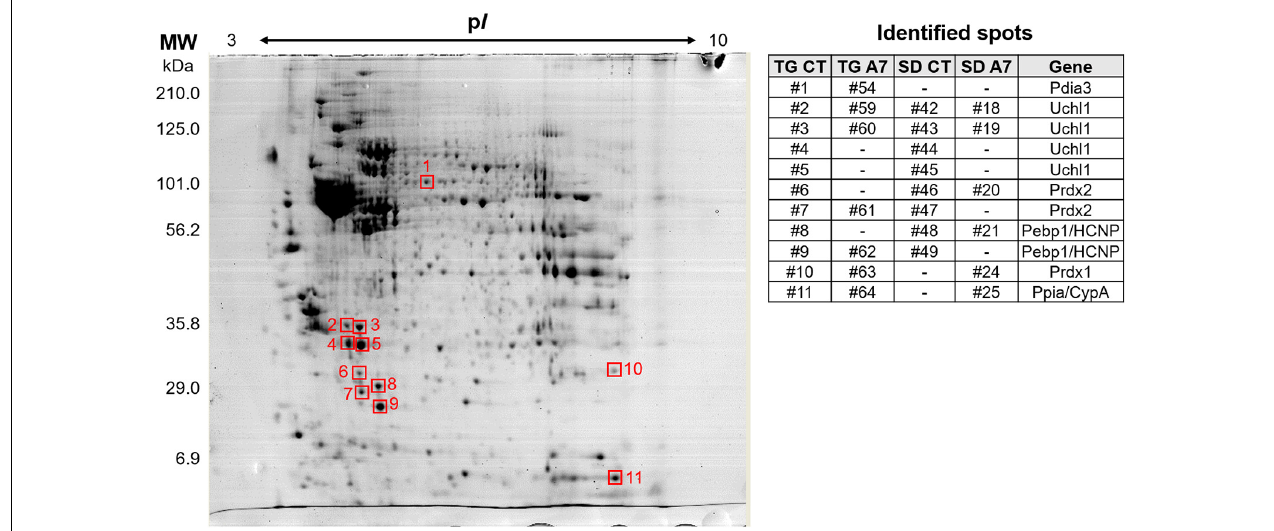
FIGURE 5 | Representative 2-DE gel image of DIGE-stained proteins (gray view). The represented gel is from the TG CT group and the squares indicate the identified spots. The panel on the right shows the number of the matched spots identified in each analyzed group, where (-) means not detected. The panel also include the gene from the identified protein. Pdia3, protein disulfide-isomerase A3; Uchl1, ubiquitin carboxyl-terminal hydrolase isozyme L1; Prdx2, peroxiredoxin-2; Pebp1/HCNP, phosphatidylethanolamine-binding protein 1; Prdx1, peroxiredoxin-1; Ppia/CypA, peptidyl-prolyl cis-trans isomerase A/cyclophilin A.